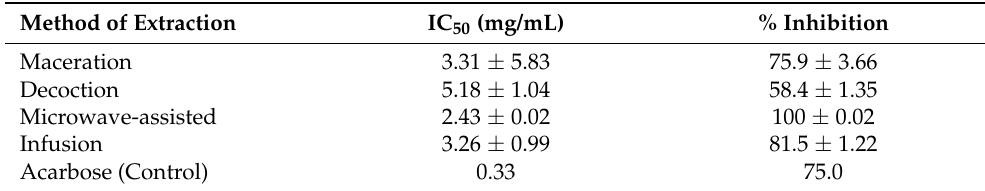
Table 2. α -glucosidase inhibition activity and IC 50 by different aqueous extracts of T. claveryi and acarbose.